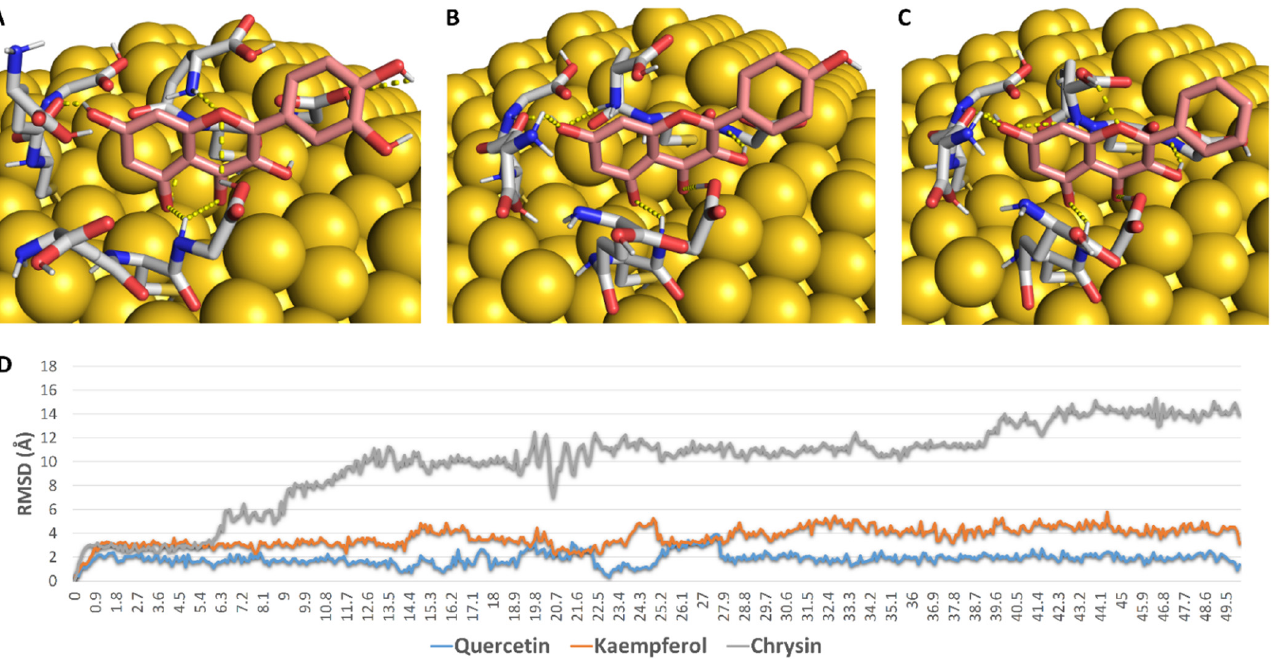
Figure 7. ( A – C ): Binding mode of quercetin, kaempferol, and chrysin with GSH molecules covalently linked to gold molecules on the surface of GNP. ( D ): RMSDs of these flavonoids during the course of 50 ns MDS.